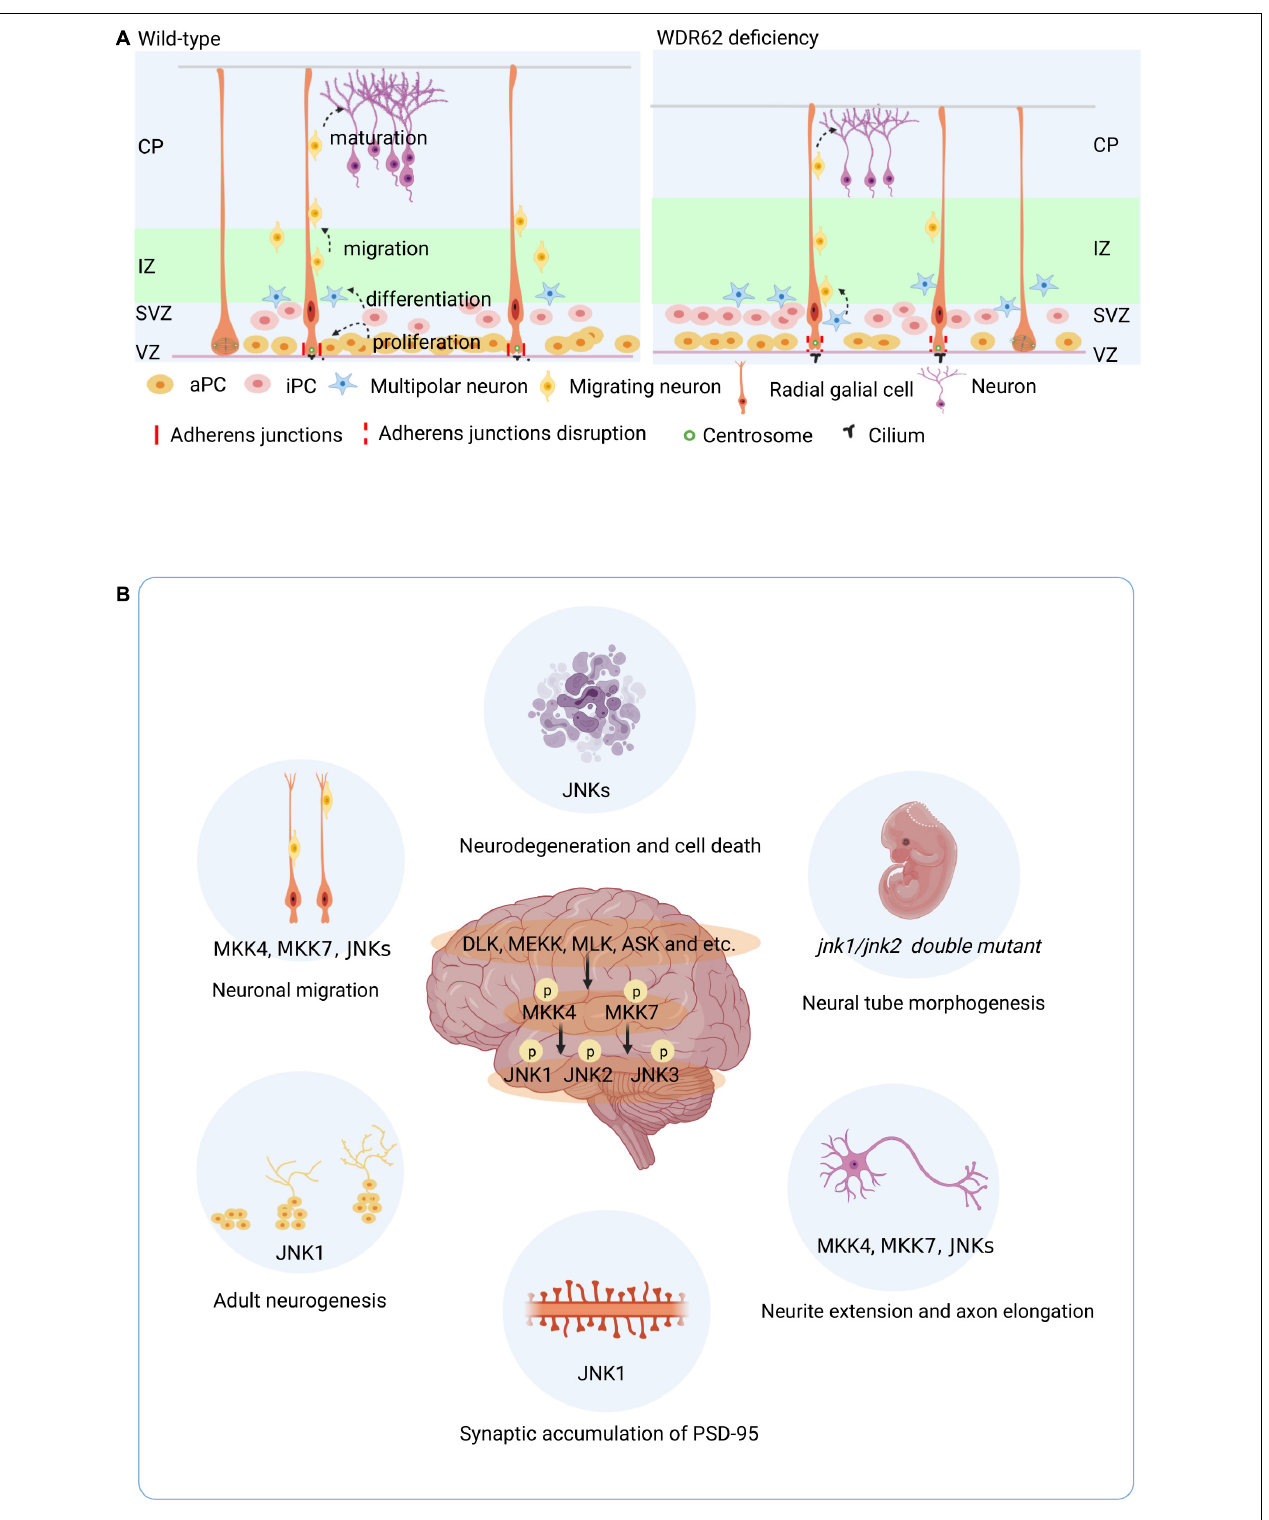
FIGURE 2 | Roles of WDR62 and JNK signaling in brain. (A) WDR62 control of embryo brain cortical neurogenesis. Development of the mammalian cortex requires precise timing of proliferation/self-renewal of neural progenitor cells (NPCs) differentiation, neuronal migration, and maturation. WDR62 depletion leads to premature differentiation of neural progenitor cells with long cilia and disrupted adhesion junction proteins in the VZ. (B) Diverse role of JNK signaling in the brain. aPC, apical precursor cell; CP, cortical plate; iPC, intermediate precursor cell; IZ, intermediate zone; SVZ, subventricular zone; VZ, ventricular zone.